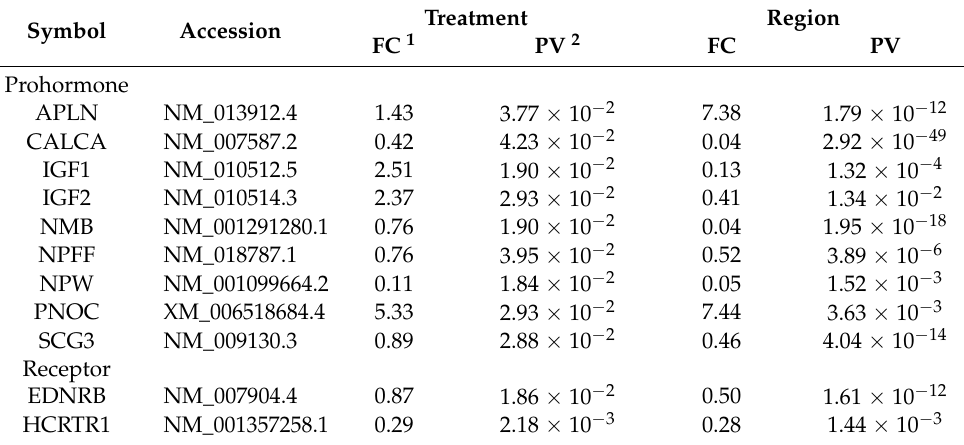
Table 2. Neuropeptide prohormone and receptor transcript isoforms and genes that present sig- nificant (FDR-adjusted p -value < 0.05) effect of nitroglycerin-elicited hypersensitivity to pain and significant (FDR-adjusted p -value < 0.05) region